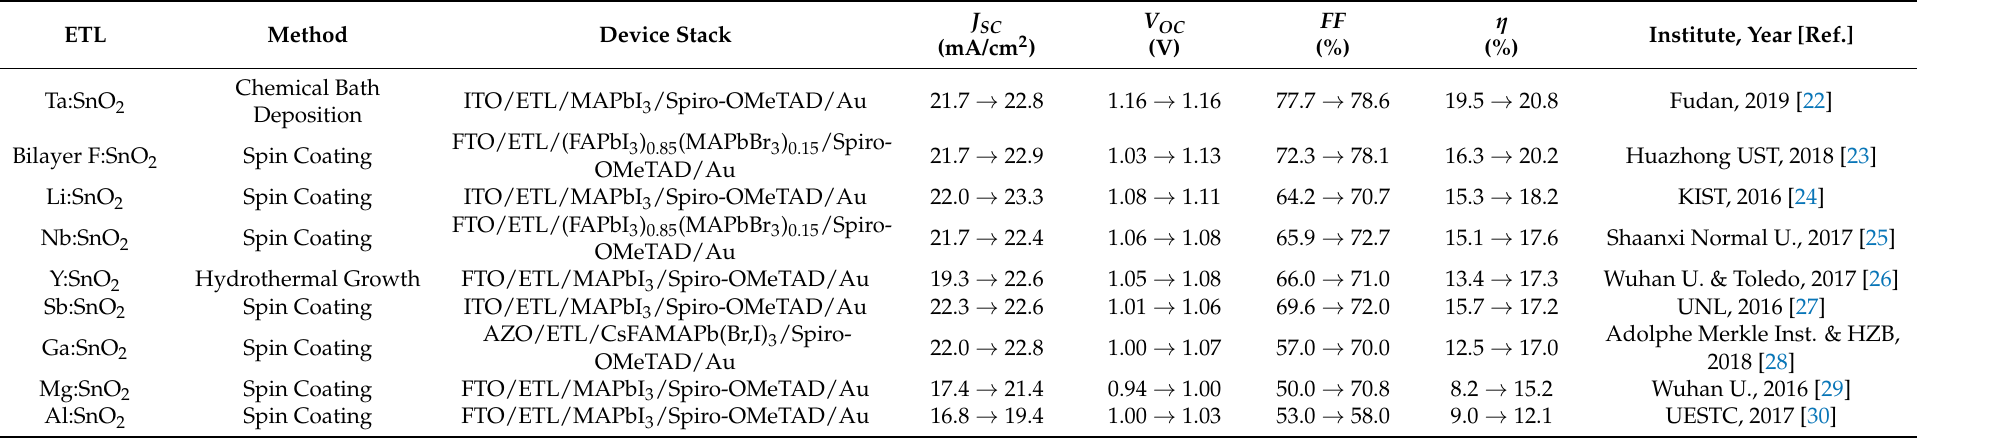
Table 1. Summary of perovskite-solar cells based on elemental doping of SnO 2